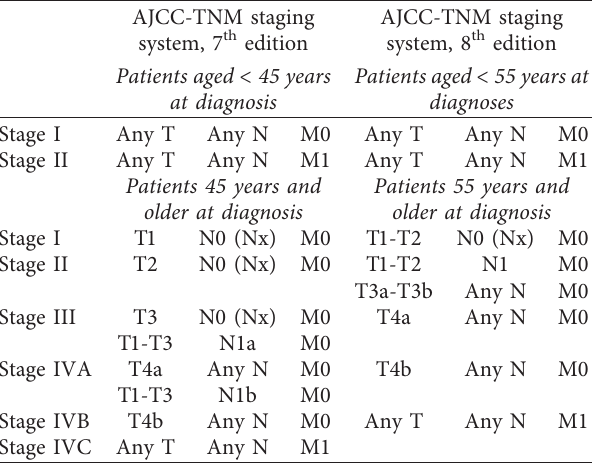
Table 1: Comparison between the 7 th and the 8 th edition of the AJCC-TNM staging system for differentiated thyroid carcinoma